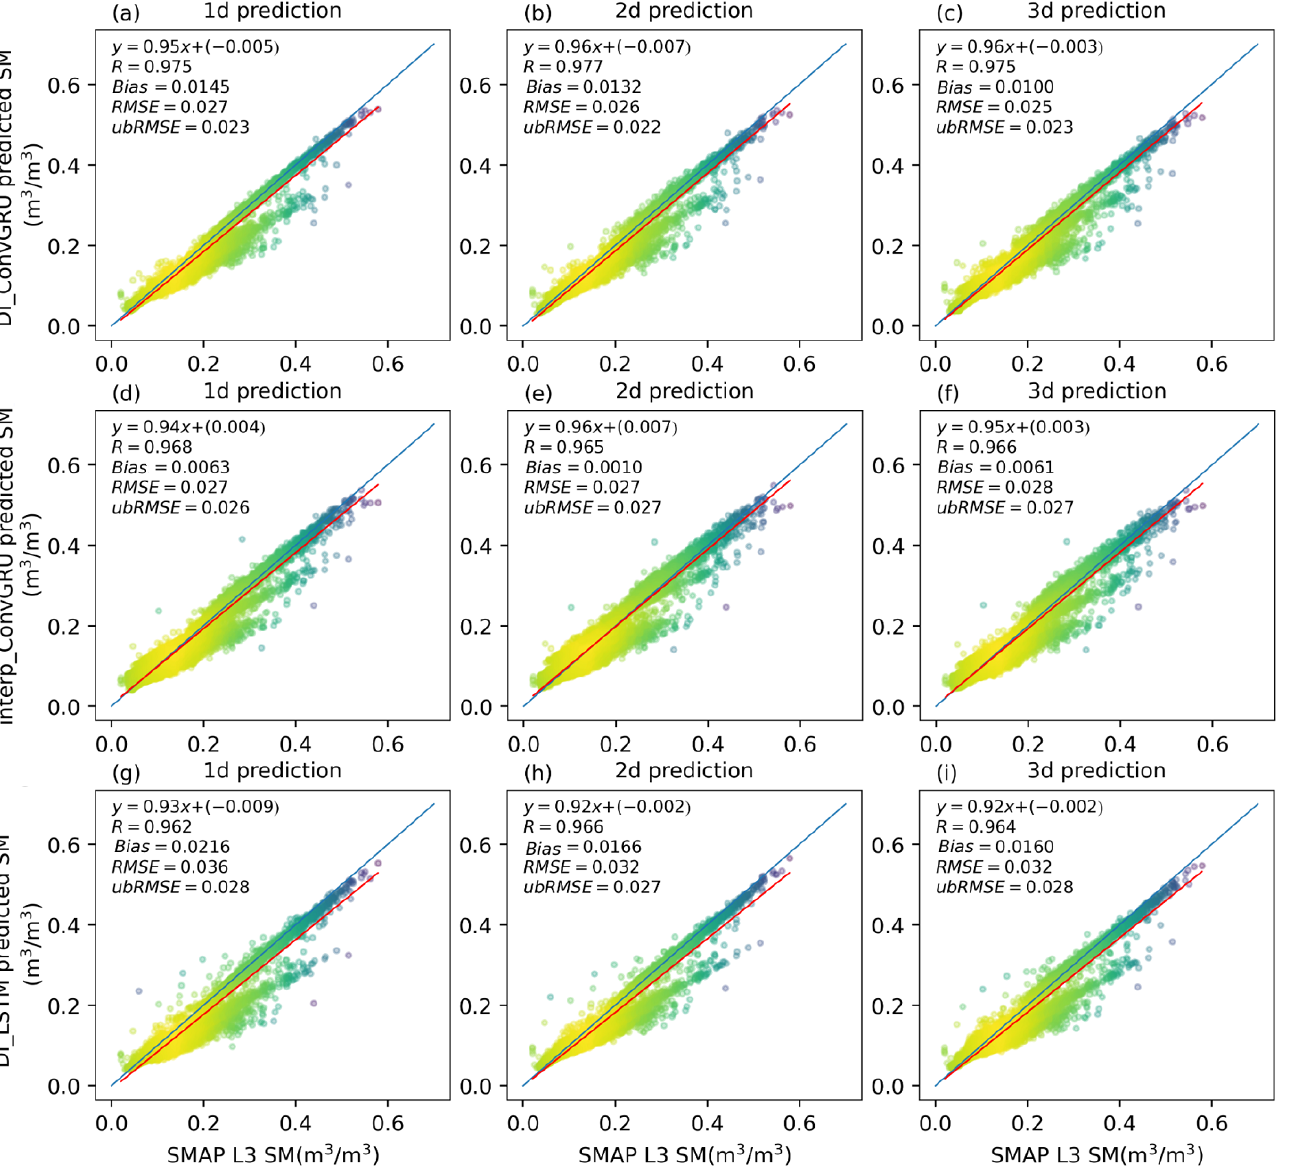
Figure 3. The density scatter plot of the predicted SM and SMAP L3 SM by DI_ConvGRU ( a – c ), interp_ConvGRU ( d – f ) and DI_LSTM ( g – i ) for 1-day, 2-day, and 3-day forecasts. The blue line is the 1:1 line and the red line is the regression line. Yellow indicates high density and purple indicates low density.